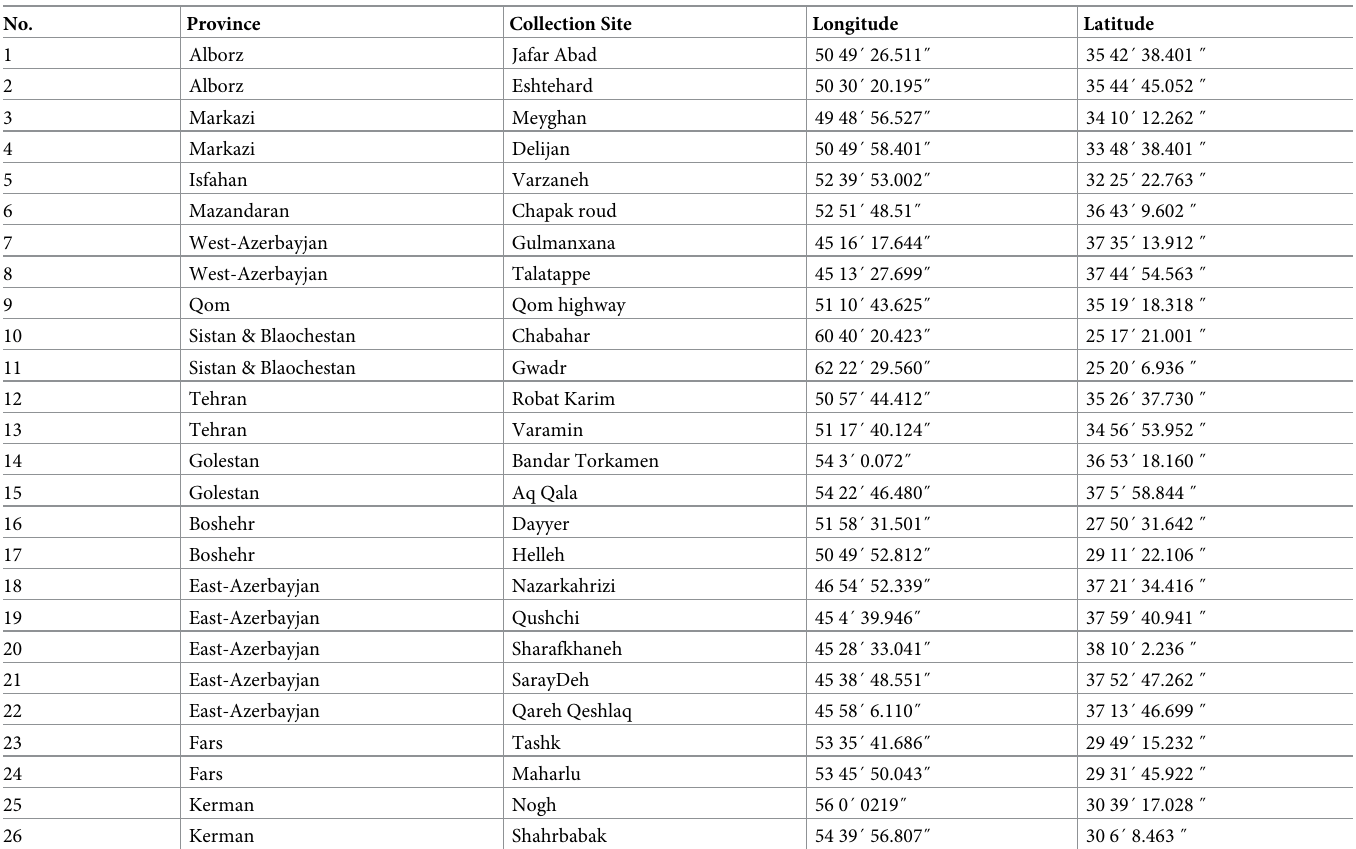
Table 1. Geographic information of Salicornia populations that were collected in this study.